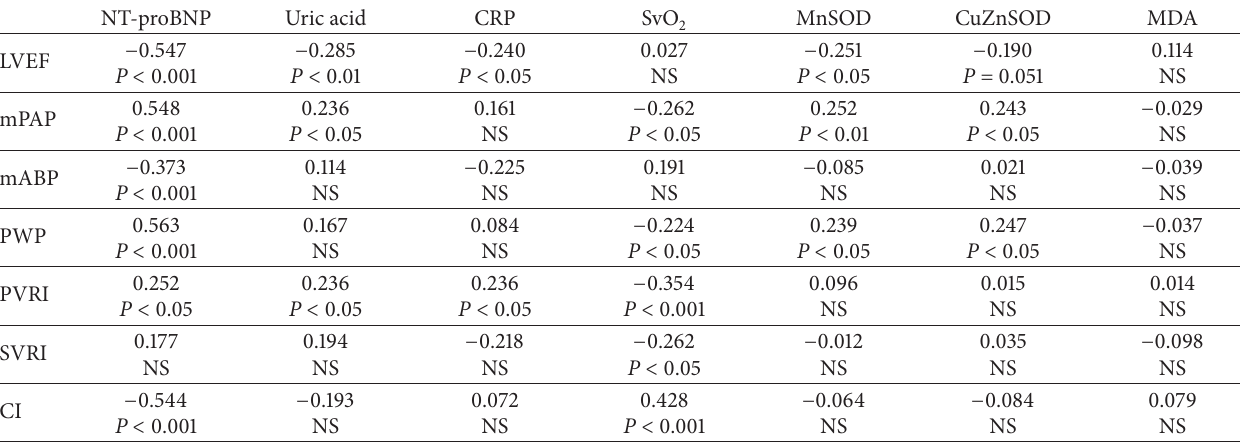
Table 5: Spearman 𝑟 correlation between biomarkers and left ventricle ejection fraction and hemodynamic parameters.